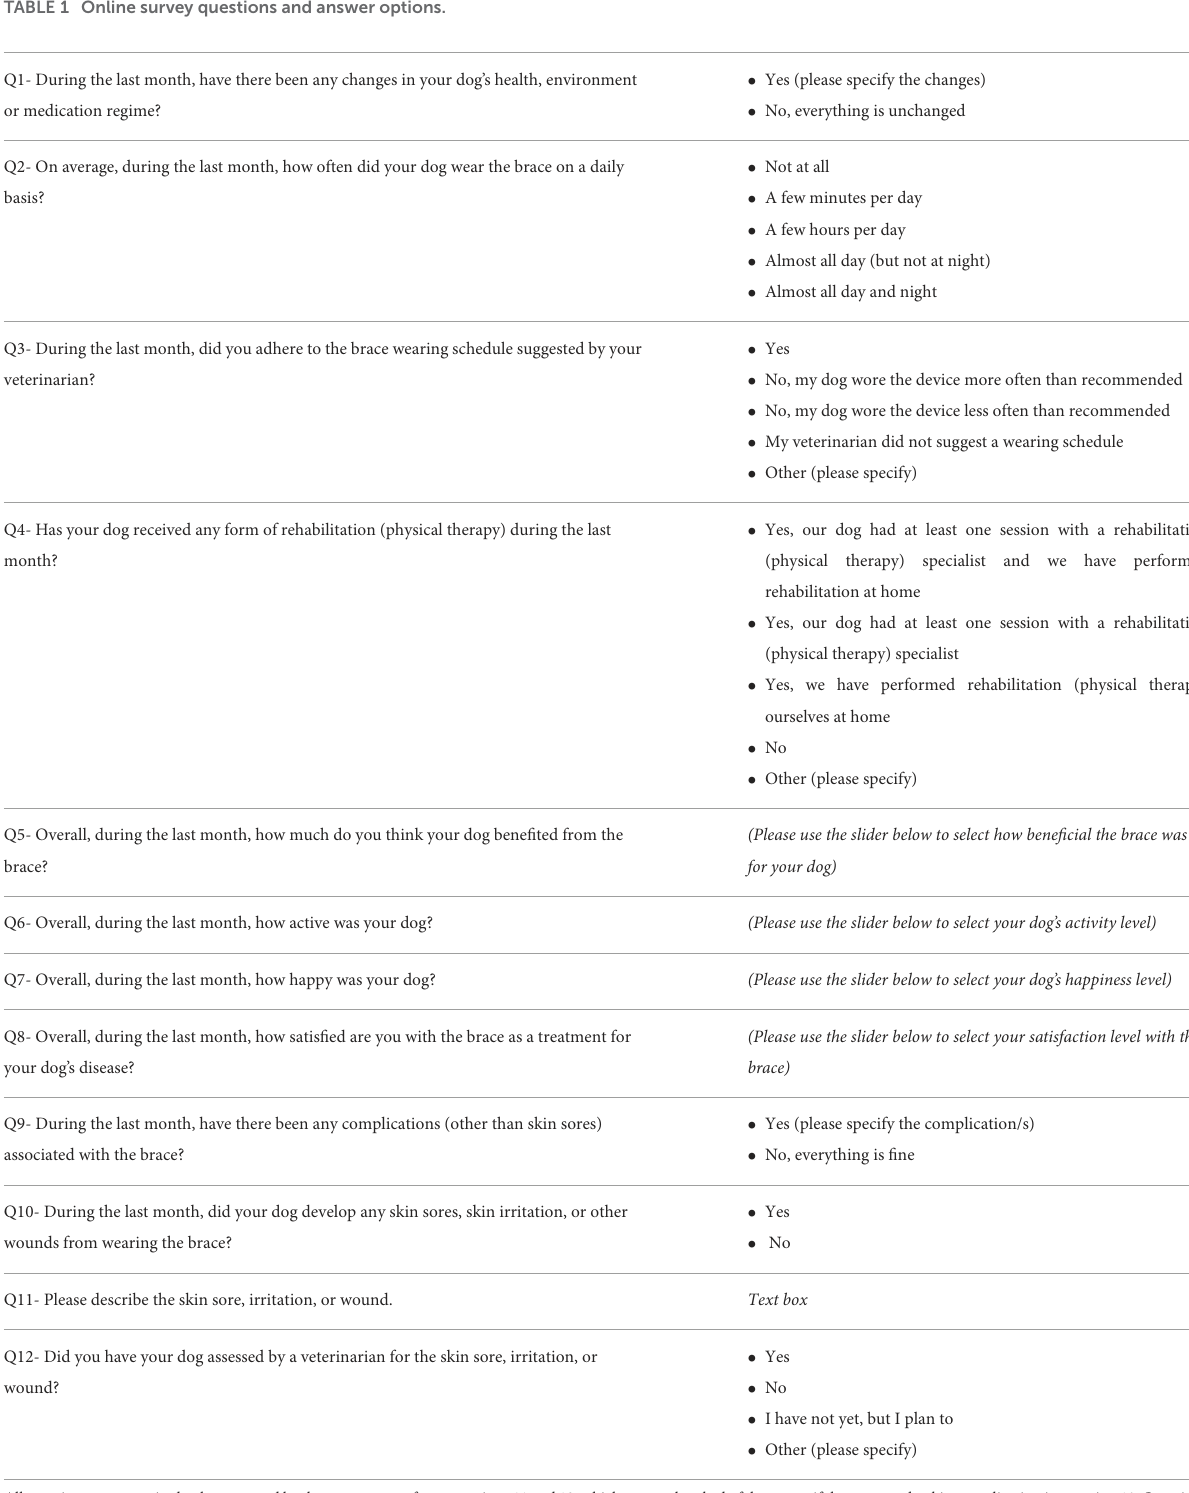
TABLE 1 Online survey questions and answer